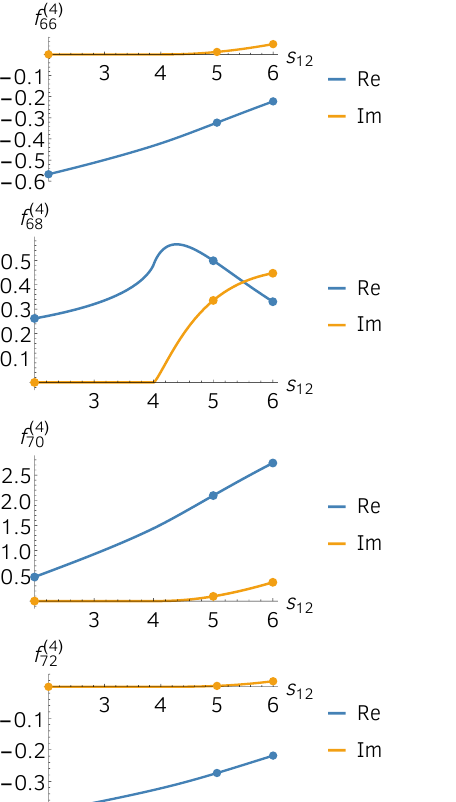
Figure 2 . Plots of the elliptic integral sectors, for s 13 = (cid:0) 1 ; p 2 at order (cid:15) 4 , obtained by series expanding along the contour (cid:13) thr . The solid points represent values computed numerically with the software FIESTA